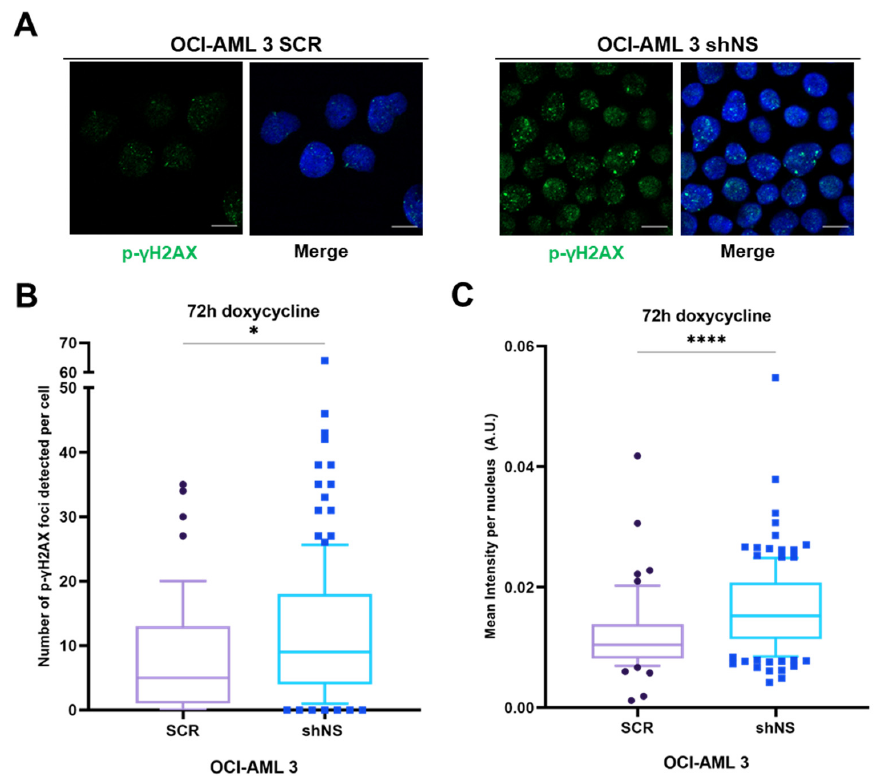
Figure 3. NS silencing in OCI-AML 3 cell lines induces higher DNA damage rates. ( A ) Representative immunofluorescence images (scale bar = 10 µ m) of OCI-AML 3 cells not silenced (SCR) and silenced (shNS) for NS protein after 72 h induction with doxycycline. Cells were stained with anti- p- γ H2AX antibody (green) to evaluate DNA damage foci within cell nuclei. Merge images are re- ported for each figure in which, beside anti-p- γ H2AX foci, Hoechst 33342 (blue) staining corre- sponds to cell nuclei. ( B ) Distribution of the number of foci detected per each single cell analyzed with FoCo software from 10 images for, respectively, SCR and shNS OCI-AML 3. Medians for each distribution are highlighted in the box plot. * p < 0.05, non-parametric Student’s t -test. ( C ) Distribu- tion of mean intensity per nucleus per each single cell measured for each condition of OCI-AML 3 cell lines after 72 h of doxycycline treatment by using FoCo software. Medians for each distribution are highlighted in the box plot. **** p < 0.0001, non-parametric Student’s t -test. 2.5. Nucleostemin-Silenced Cells Are More Sensitive to DNA Damage Induced by Etoposide Treatment To better understand to what extent the homologous recombination repair pathway is affected by NS depletion, we decided to treat both SCR and shNS cells with different concentrations of etoposide (ETO), which is known to elicit DNA damage by inducing double-strand breaks (DSBs) through the inhibition of topoisomerase II [34] (Figure 4). We first treated cells with vehicle to evaluate the putative effects of DMSO on foci number. As expected, we observed a significantly higher median value in the number of foci de- tected per cell in vehicle-treated OCI-AML 3 shNS, while distributions of overall intensity values per nucleus were comparable in both shNS and SCR OCI-AML 3 cells (Figure 4A). Then, cells were treated for 24 h with two different concentrations of etoposide (ETO; 0.125 µM and 0.5 µM) in order to induce substantial DNA damage without, however, leading to massive cell death. Upon treatment with 0.125 µM etoposide, NS-silenced OCI-AML 3 cells suffered a significantly higher DNA damage rate in comparison with their SCR con- trol treated in the same way, as reported in Figure 4B. Moreover, upon treatment with the higher dose of 0.5 µM etoposide, although the distributions of number of foci detected